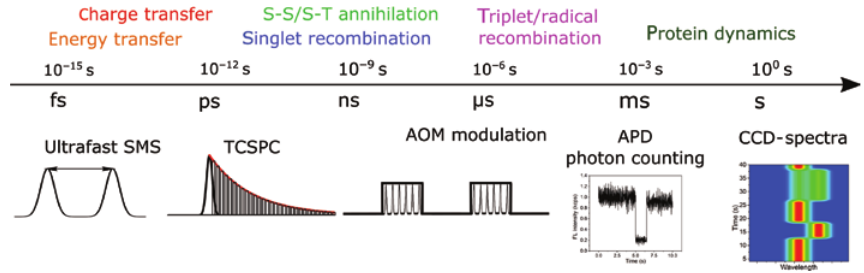
Figure 2: Timescales of photosynthetically relevant electronic processes observable by SMS. Top: processes taking place at the indicated timescale. Bottom: corresponding SMS techniques which can be used for their measurement; see text for further